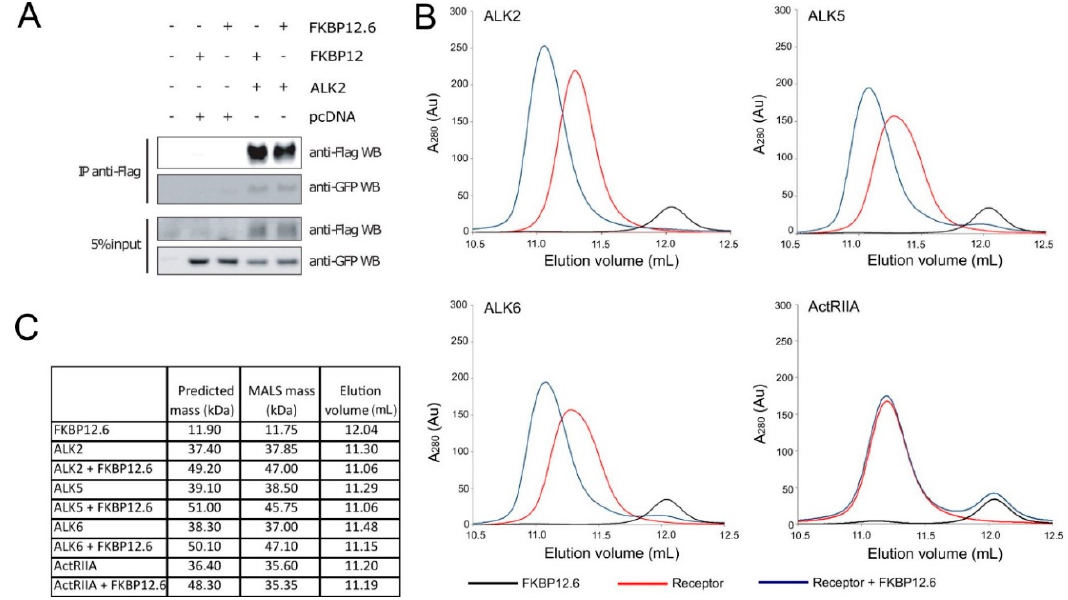
Figure 1. FKBP12.6 binds to type I receptors in a 1:1 complex. ( A ) Immunoprecipitation (IP) to assess ALK2 binding to FKBP12 or FKBP12.6 in MDA-MB-231 cells transfected with FLAG-tagged ALK2 and GFP-tagged FKBPs. Proteins were detected by Western blot (WB) using the indicated antibodies. ( B ) Analytical size exclusion chromatography elution profiles for the indicated individual recombinant proteins and upon mixing with FKBP12.6. ( C ) Multi-angle light scattering (MALS) data for the peak of the indicated elution samples.